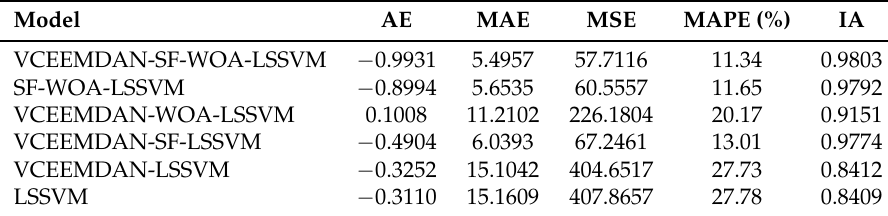
Table 3. Experiment I forecasting results in Beijing.